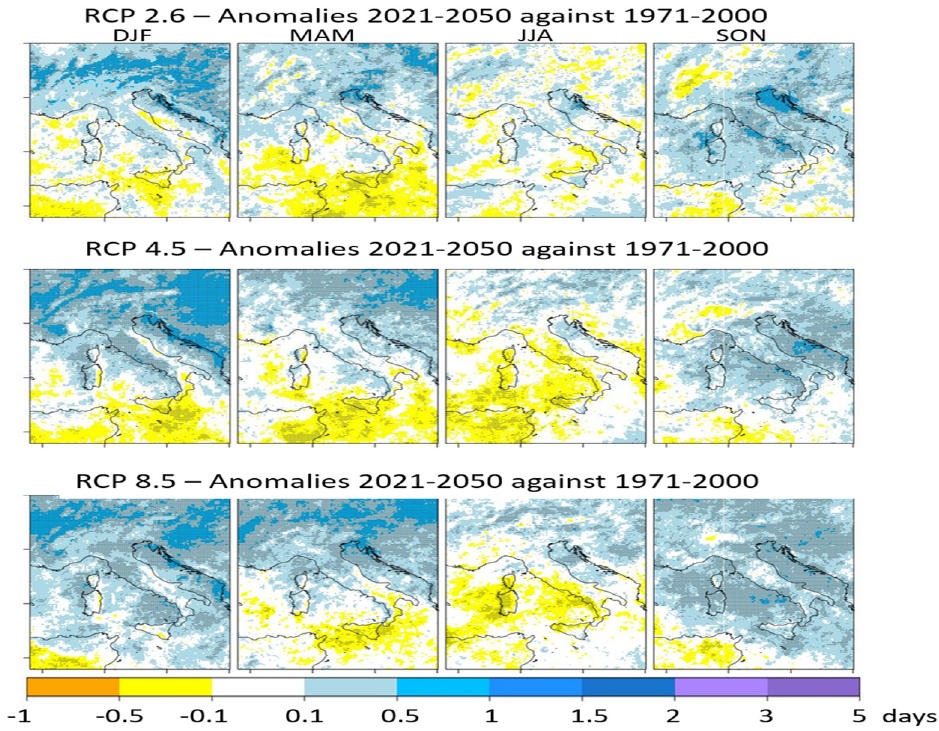
Figure 14. Seasonal R99PTOT anomalies (unit = number of days), expressed as difference between the number of events (number of days) projected in the future period 2021–2050 (DJF, MAM, JJA, SON, respectively, from first to fourth column) and those in the reference period 1971–2000 under